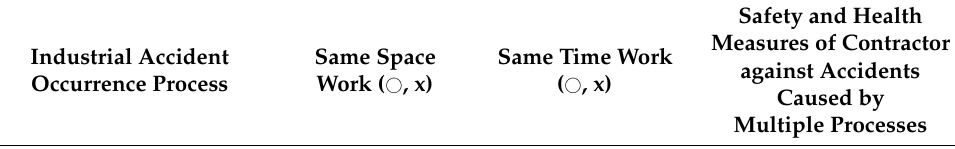
Table 6. Cases for being caught in equipment or machinery by multiple processes in the